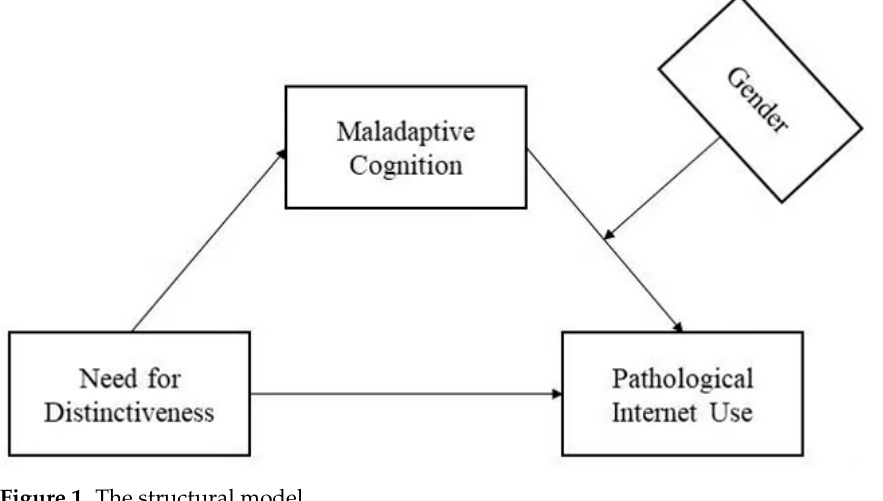
Figure 1. The structural model.